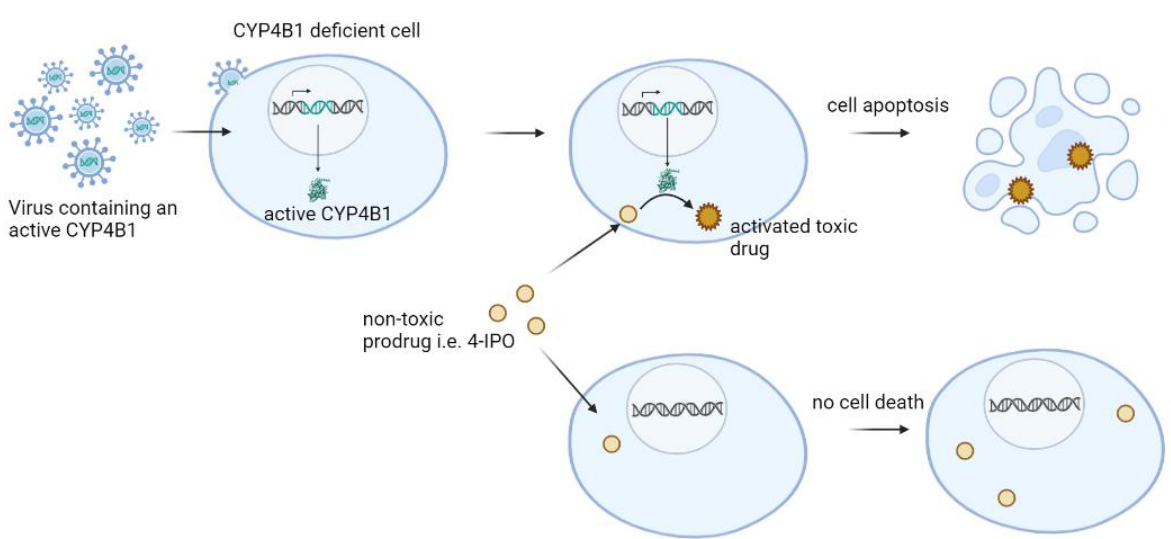
Figure 3. Schematic representation of a CYP4B1-based suicide gene system. CYP4B1-deficient cells are transduced with integrating viral vectors to express an active CYP4B1 protein. This enzyme converts a non-toxic substance (protoxin) into a cellular toxin only in CYP4B1-positive cells.